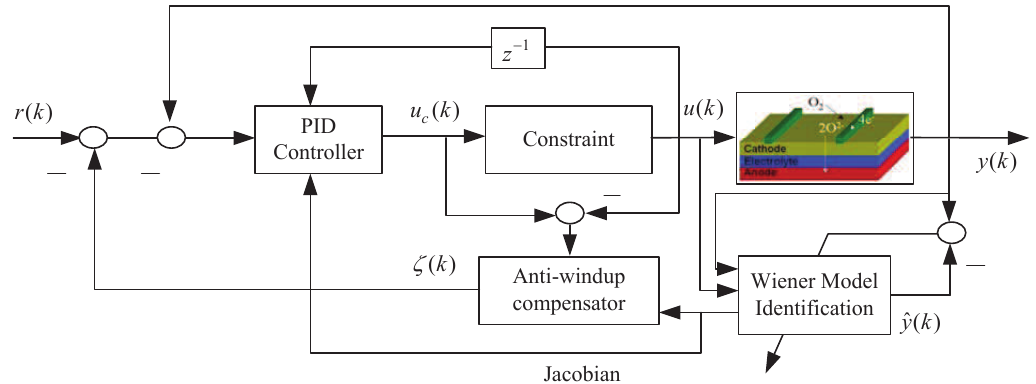
Figure 5. Structure of the presented control strategy for